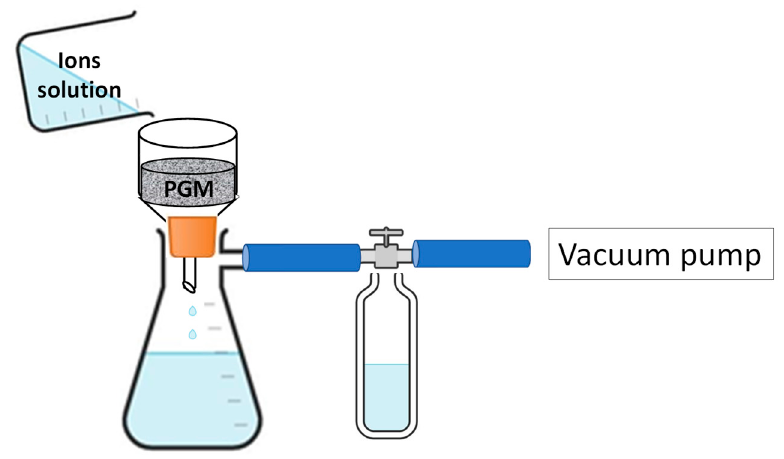
Figure 2. Filtration experimental setup.